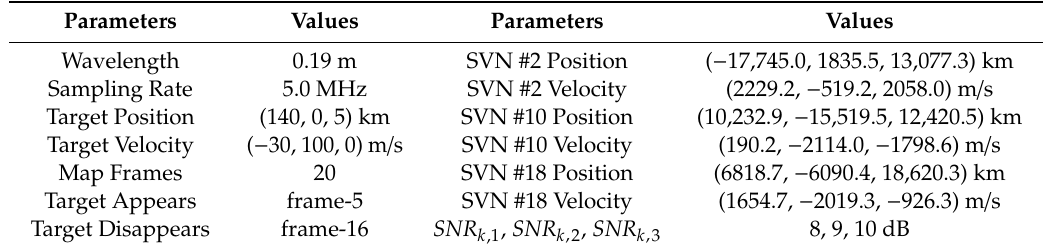
Table 1. Main simulation